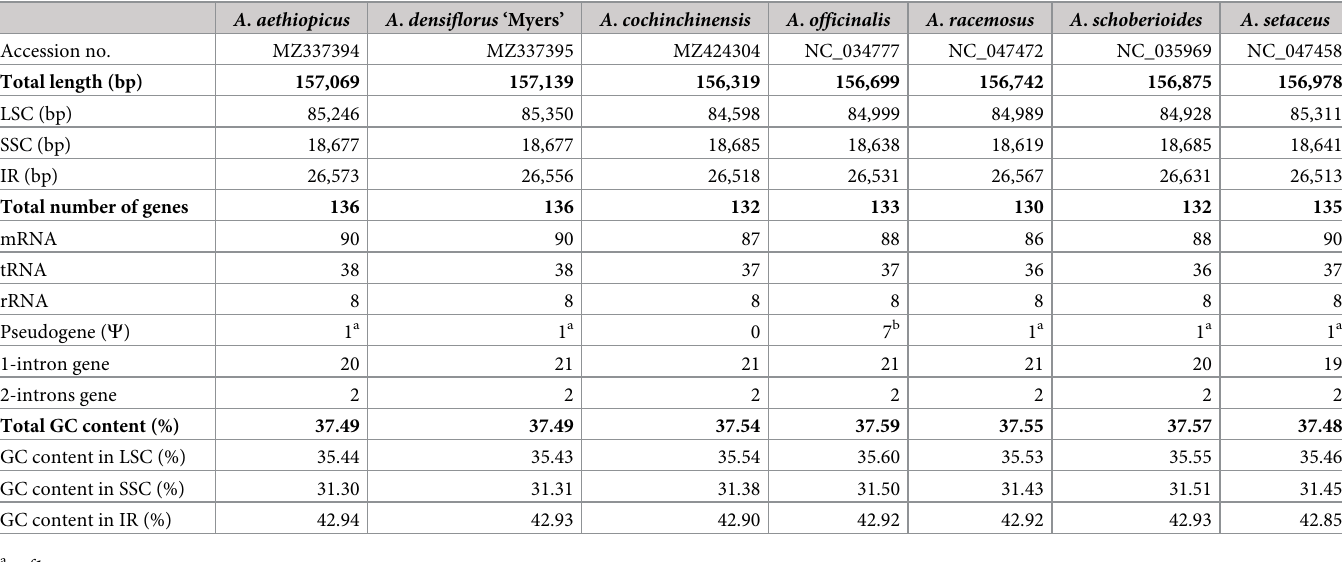
Table 2. Summary on the cpDNA genome structure of the seven Asparagus